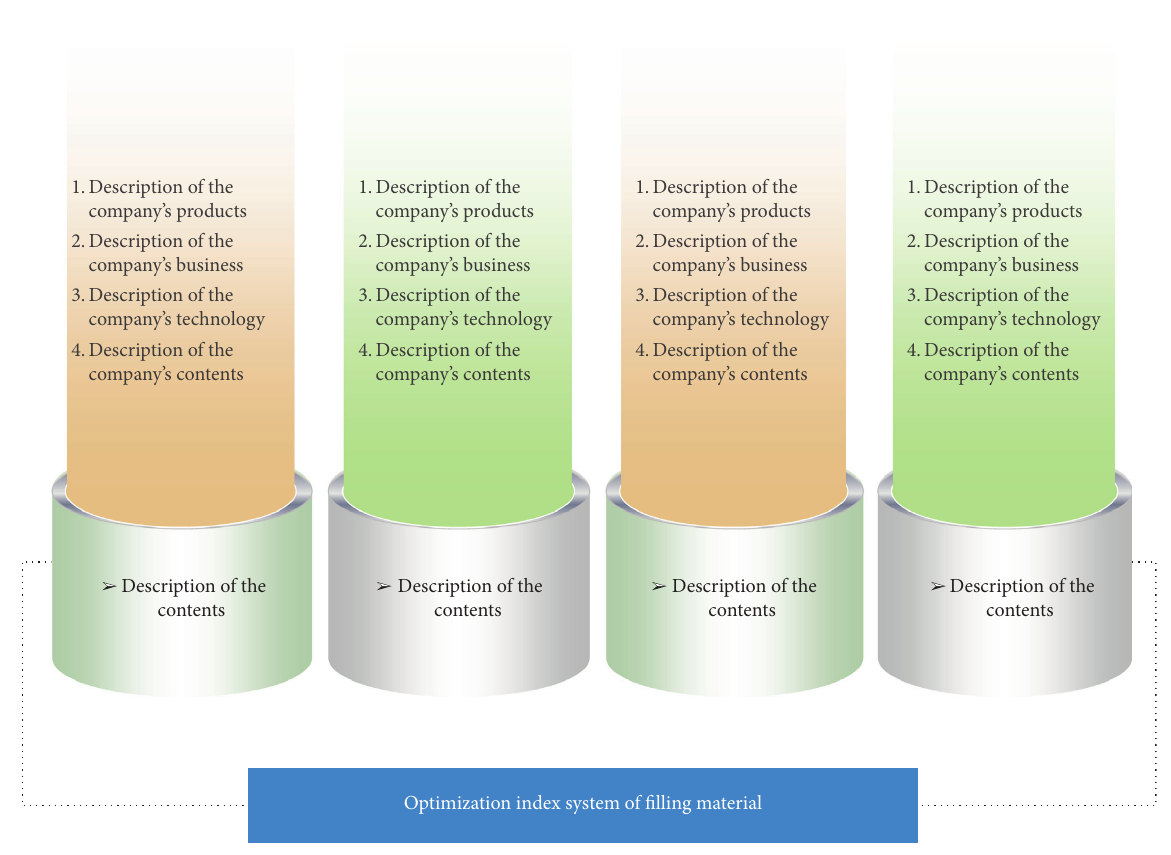
Figure 3: Optimization index system of filling material. Table 3: The judgment matrix A